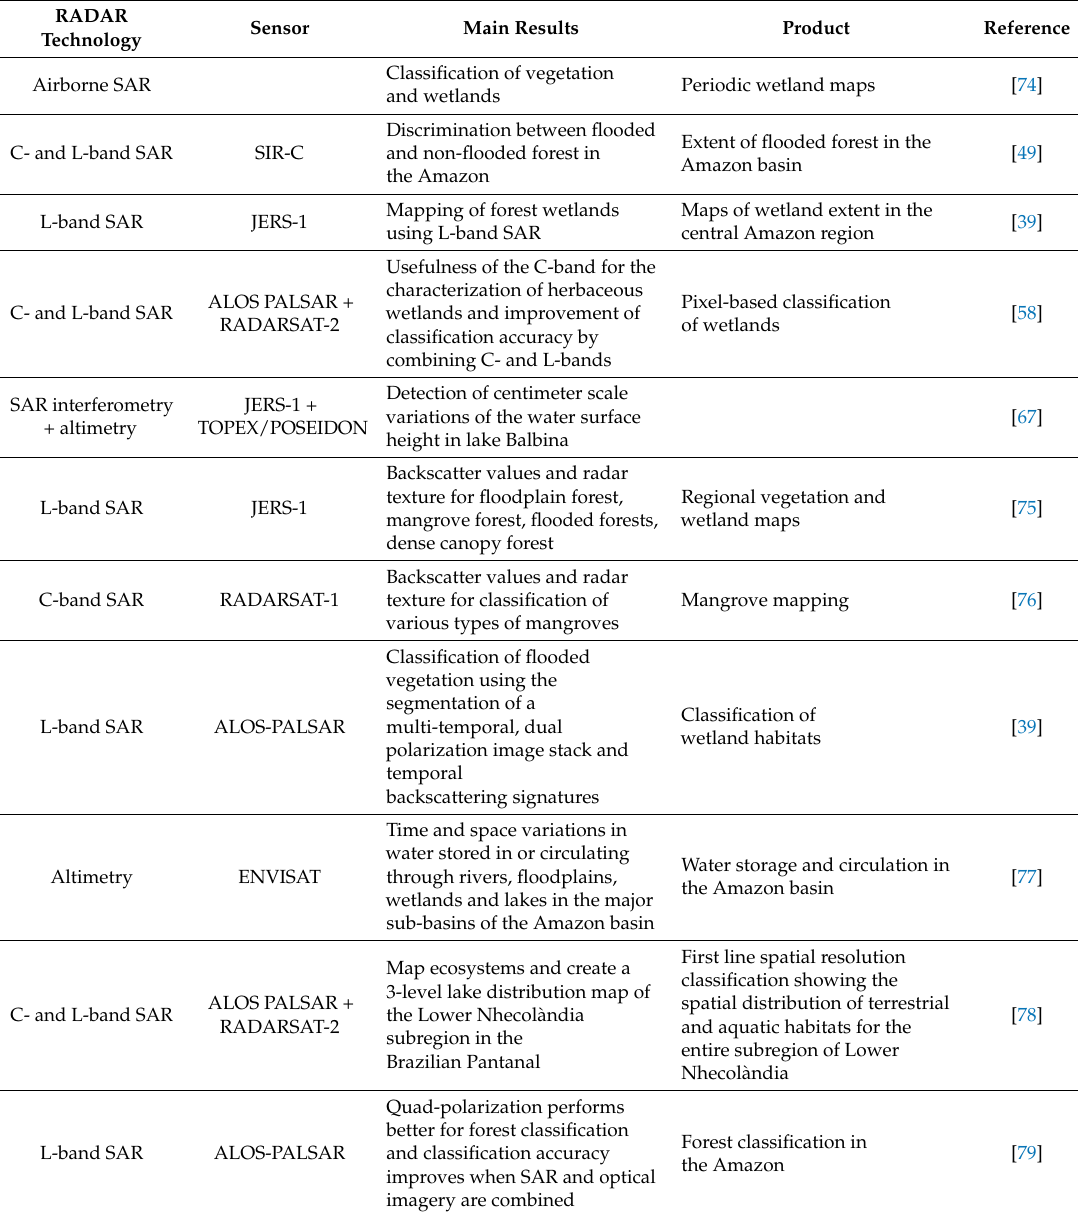
Table 4. A summary of studies using SAR remote-sensing and Altimetry for the characterization of wetland types in the Amazon